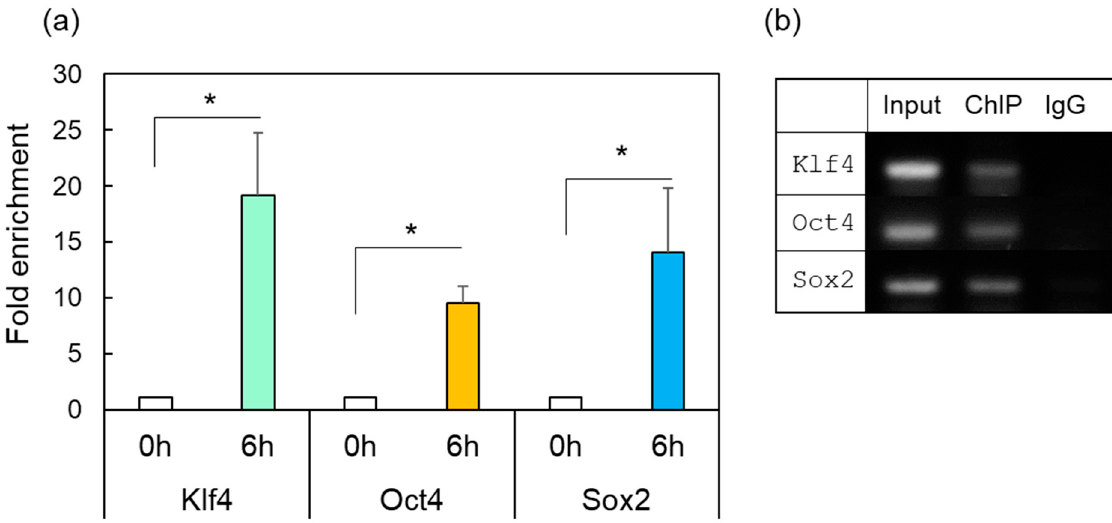
Figure 4. ChIP-enriched DNA was prepared using preimmune serum (IgG) or anti-HSF1 antibody from the control (0 h) or damaged zebrafish retina after ONI (6 h). ( a ) The immunoprecipitated DNA of Klf4 , Oct4 , and Sox2 were analyzed by real-time PCR. Each ChIP signal was divided by the no-antibody signals (IgG), representing the ChIP signals as the fold increase in signals relative to the background signals. ( b ) Gel electrophoresis image using the ChIP samples. The input was used as an internal positive control for the ChIP assay. Five to six experiments were repeated with different retinas under each experimental condition. Data are expressed as the mean ± SEM of independent experiments and analyzed by one-way ANOVA, followed by Scheffe’s multiple comparisons. Statistical significance was set at * p < 0.05.